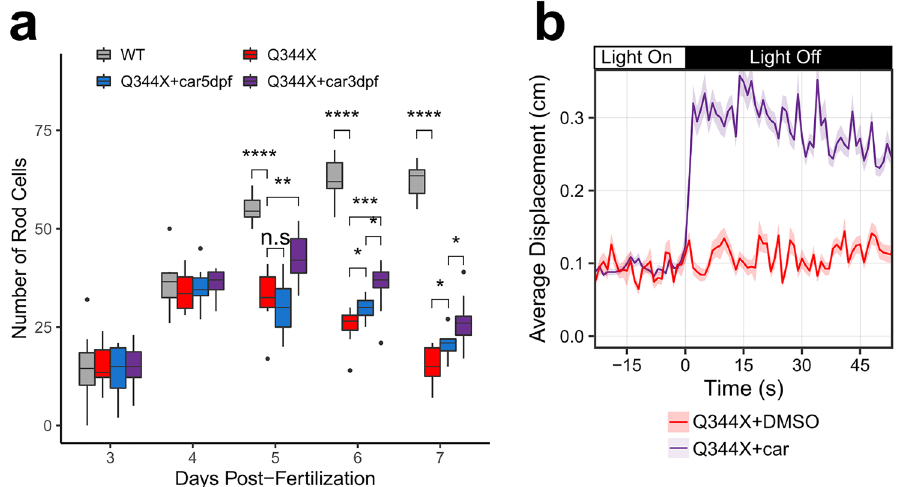
Figure 4. Carvedilol treatment beginning at 3 dpf increased rod numbers in the Q344X larvae greater than the treatment beginning at 5 dpf. ( a ) Quantification of rod number in WT, Q344X treated with DMSO beginning at 3 dpf, and Q344X treated with carvedilol beginning at 3 dpf or 5 dpf. Rods were quantified from their retinal cryosections beginning at 3–7 dpf. There was no statistically significant difference in rod number between groups at 3 dpf and 4 dpf determined by one-way ANOVA (3 dpf; N = 10; F (3,36) = 0.1, p value = 0.95); (4 dpf; N = 10; F (3,36) = 0.5, p value = 0.69). There was a statistically significant difference in rod number between groups at 5 dpf through 7 dpf determined by one-way ANOVA (5 dpf, N = 10; F (3,36) = 0.1, p value < 0.0001), (6 dpf, N = 10; F (3,36) = 0.1, p value < 0.0001), (7 dpf, N = 10; F (3,36) = 0.1, p value < 0.0001). The effect of Q344X rod degeneration and carvedilol treatment on rod number was assessed post hoc by pairwise t-test with false discovery rate correction at 5 dpf (WT − Q344X, p value < 0.0001; Q344X − Q344X + car3dpf, p value < 0.001; Q344X − Q344X + car5dpf, p value = 0.36, Q344X + car3dpf − Q344X + car5dpf, p value < 0.0001), at 6 dpf (WT − Q344X, p value < 0.0001; Q344X − Q344X + car3dpf, p value < 0.0001; Q344X − Q344X + car5dpf, p value < 0.05; Q344X + car3dpf − Q344X + car5dpf, p value < 0.05), and at 7 dpf (WT − Q344X, p value < 0.0001; Q344X − Q344X + car3dpf, p value < 0.0001; Q344X − Q344X + car5dpf, p value < 0.05; Q344X + car3dpf − Q344X + car5dpf, p value < 0.05). ( b ) Carvedilol treatment of Q344X larvae beginning at 3 dpf (purple trace) displayed a significant scotopic light-off VMR when compared to Q344X larvae treated with DMSO (red trace) (Hotellings T-squared test, N = 3 replicates of 24 larvae, T = 397, df = 30, p value < 0.0001). Each trace shows the average displacement of each replicate, and the color ribbons indicate µ ±